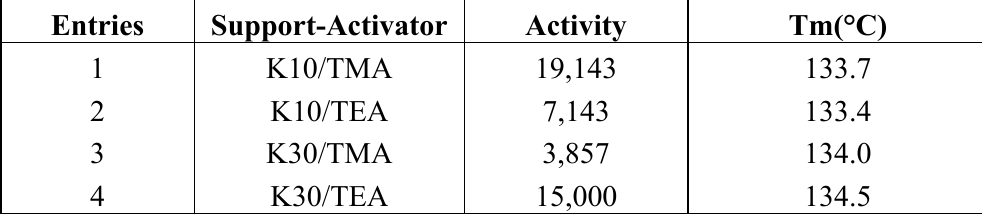
Table 3. Ethylene polymerization using modified MMT as support